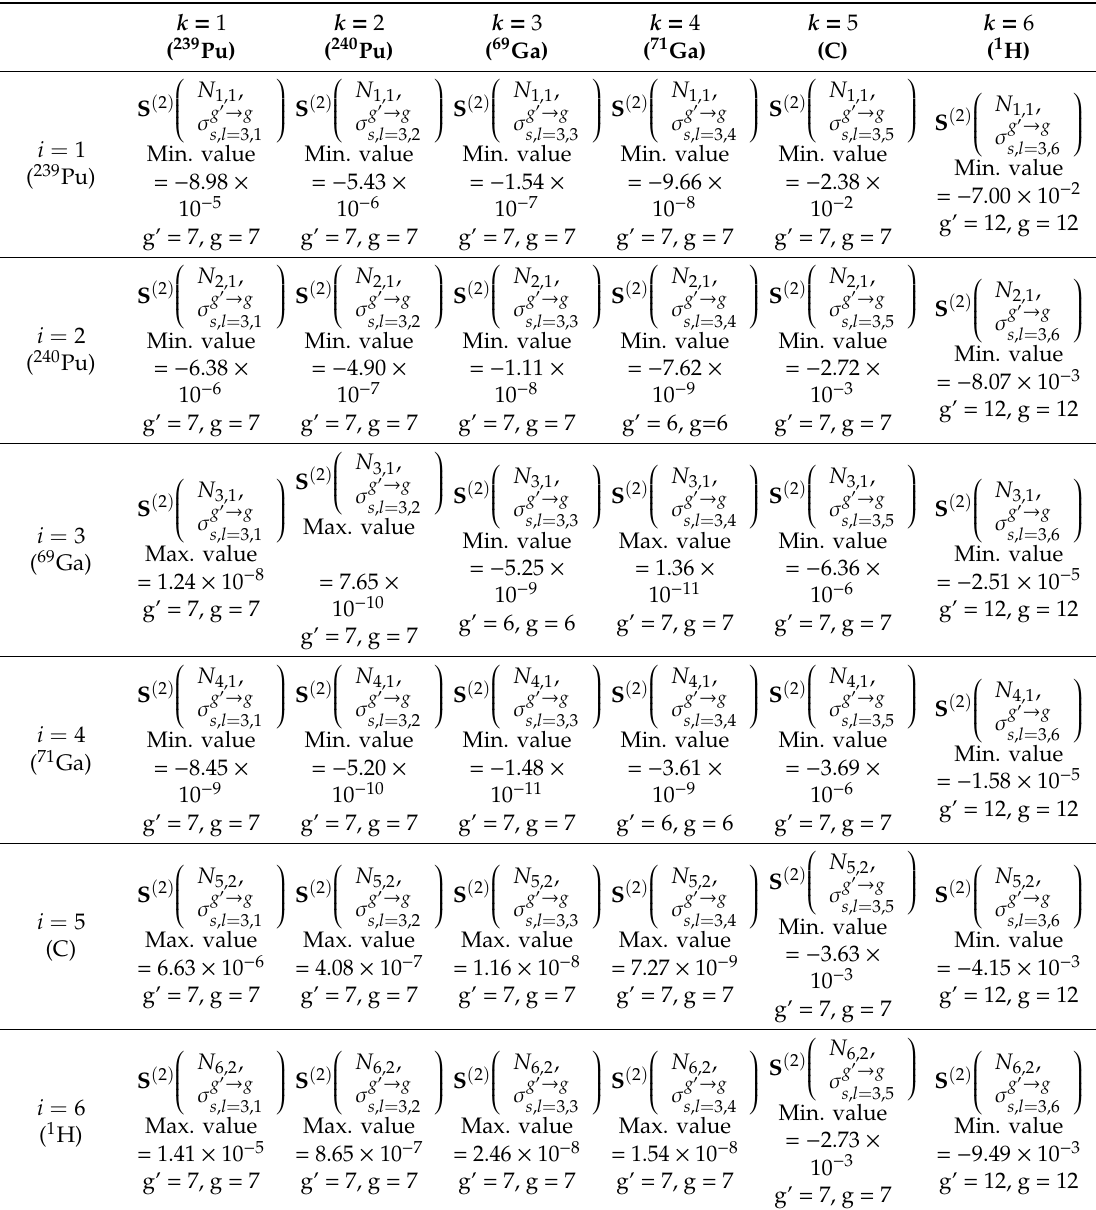
Table 18. Summary presentation of the matrix S ( 2 ) sensitivities of the leakage response with respect to the isotopic number densities and the 3rd-order ( l = 3 ) scattering cross sections for all